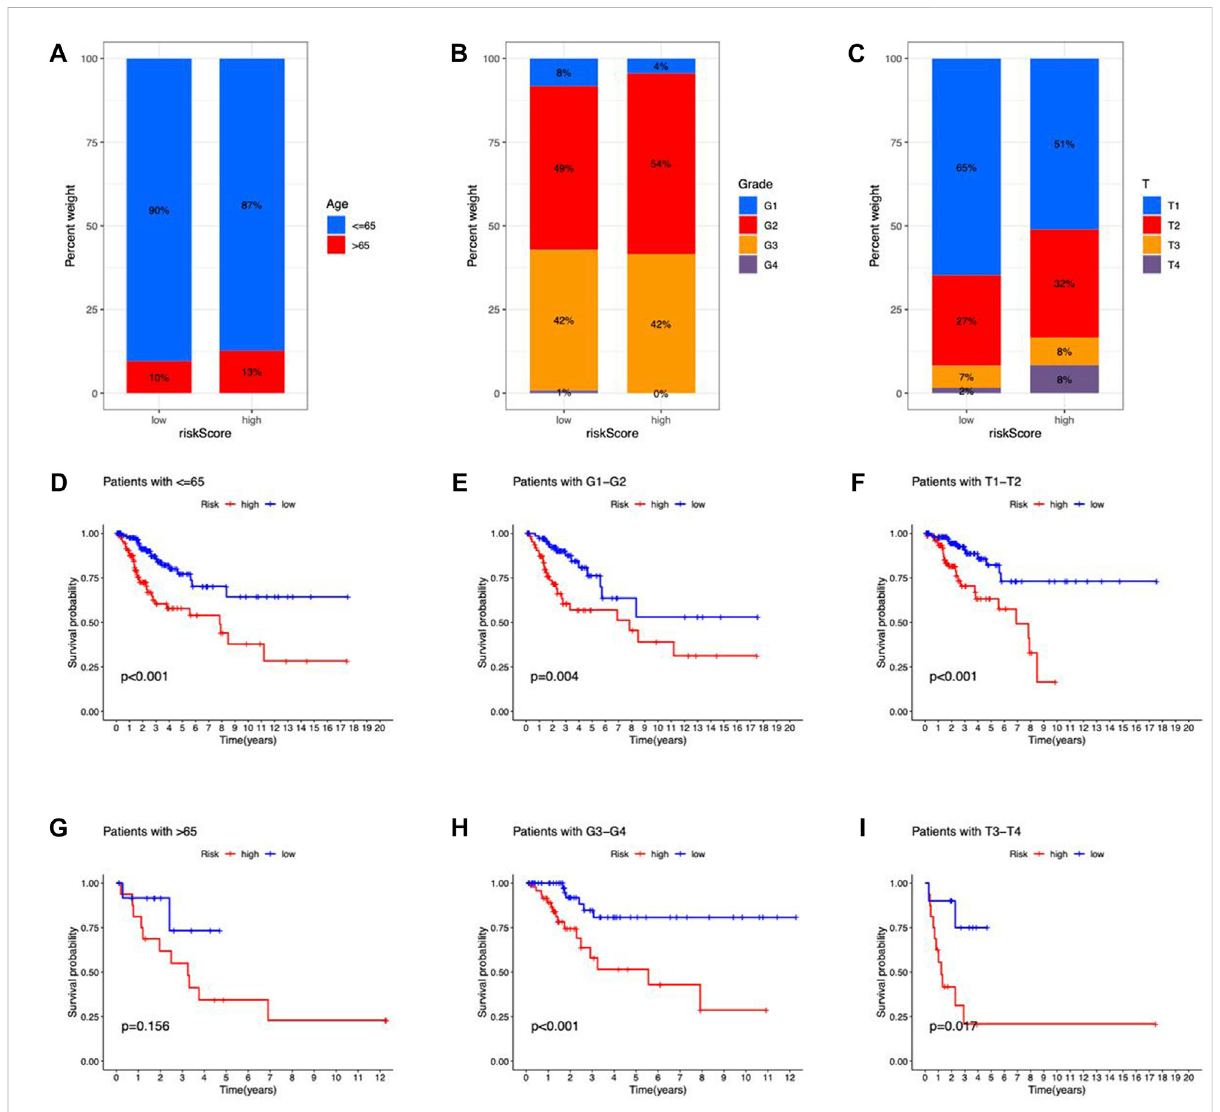
FIGURE 6 Clinicopathological features in the risk model. (A – C) Correlation between clinical characteristics and risk scores (D – I) Kaplan – Meier survival curves for subgroups